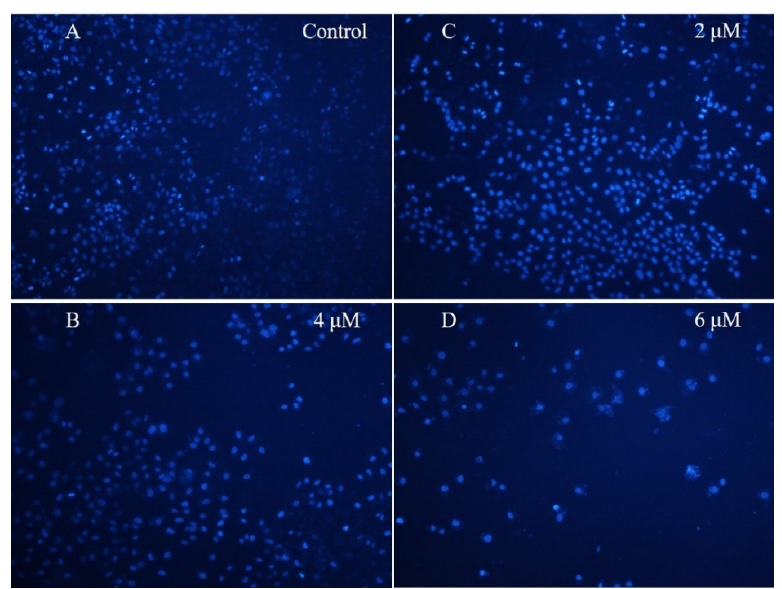
Figure 6. Morphological detection of apoptosis using 4′,6-diamidino-2-phenylindole (DAPI) staining (100×) on A549 cells treated with compound 9 : ( A ) control group; ( B ) 2 µM; ( C ) 4 µM; ( D ) 6 µM. Detection of Apoptosis Using Annexin V Fluorescein Isothiocyanate (FITC)/Propidium Iodide (PI) Staining